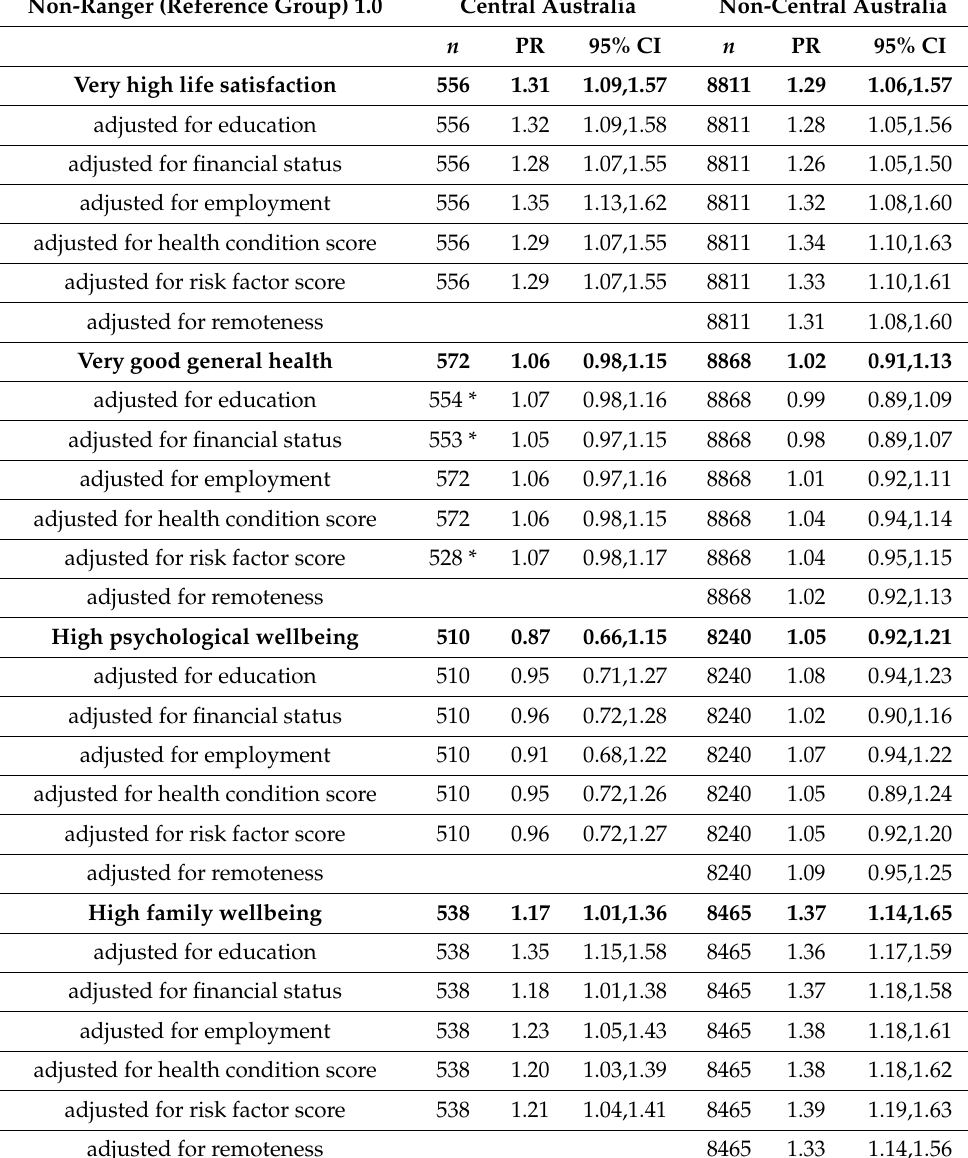
Table 4. Associations between Ranger status and wellbeing of Rangers and non-Rangers, for Central Australia and non-Central